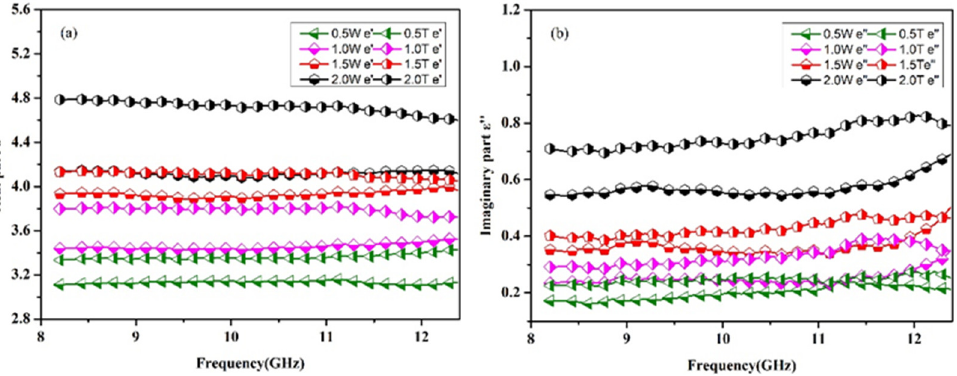
Figure 8. Comparison of complex permittivity of materials with 1wt.% CGF and different Gr contents in T and W directions in the X band. ( a ) real part, ( b ) imaginary part.